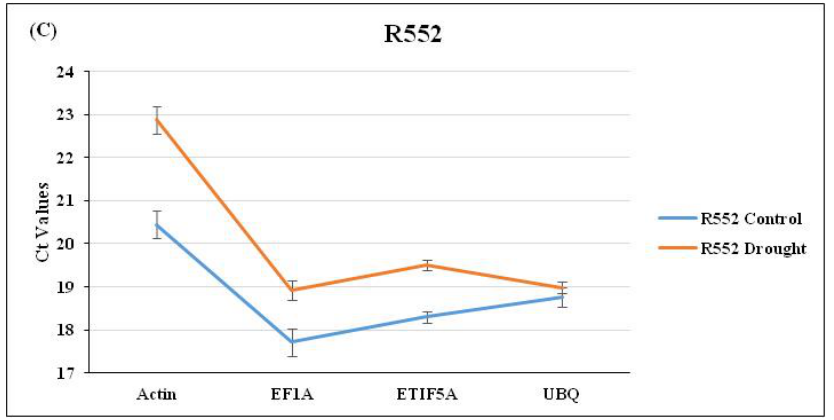
Figure 2. Expression analysis of four selected RGs ( Actin , EF1a , ETIF5A , and UBQ ) through qRT-PCR analysis in ( A ) Hira, ( B ) Mukta, and ( C ) R551 cultivars of flax. Table 3. Stability of the selected RGs in multiple flax cultivars. Stability scores of RGs were computed from the Ct values obtained from qRT-PCR data of drought stressed flax plants by using NormFinder. The groups are the combination of flax cultivar Hira-Mukta (HM), Mukta- R552 (MR), and Hira-R552 (HR), and Hira-Mukta-R552